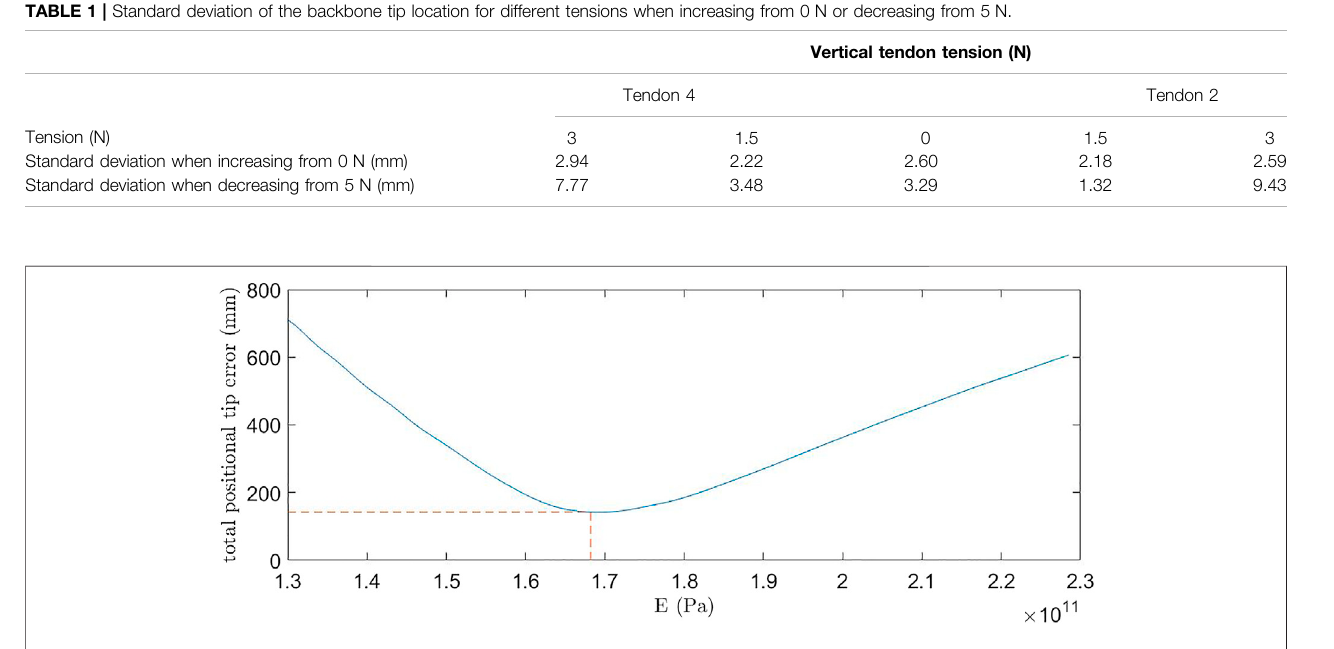
Frontiers in Robotics and AI |